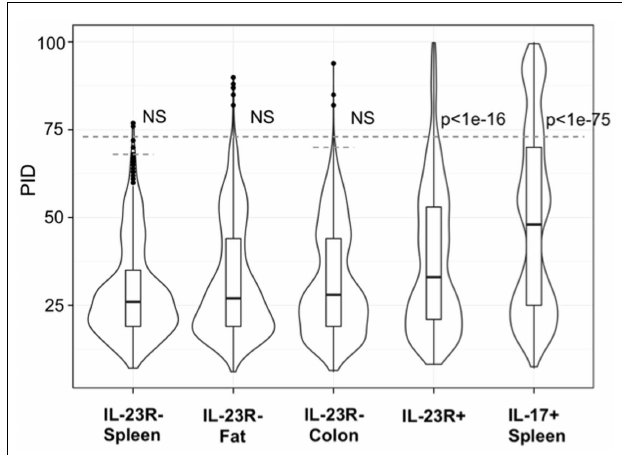
FIGURE 3 |Analysis of CDR3 paratope convergence of all unique sequences of IL-23R − γδ T cells from the spleen, fat, colon samples, IL-17F + γδ T cells from spleen and IL-23R + γδ T cells (combined from all anatomical sites) . Percent identity among aligned γ and δ CDR3 amino acid sequences for all pairwise comparisons within each group are represented in violin/Box plot. Significance assessed by the Mann–Whitney–Wilcoxon test with Bonferroni’s correction for multiple testing given a = 0.01 set to p < 0.001 to be considered significance. Dotted